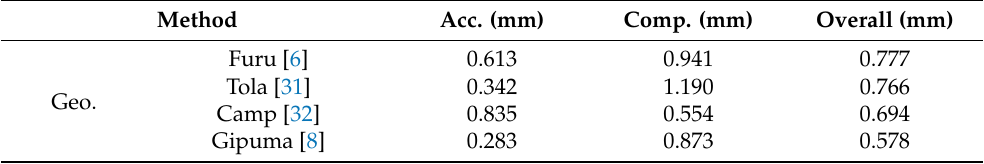
Figure 8. Comparison of reconstructed 3D point clouds. Table 1. Quantitative results on DTU evaluation benchmark. Geo. represents traditional geometric methods. Sup. represents supervised methods. UnSup. represents unsupervised